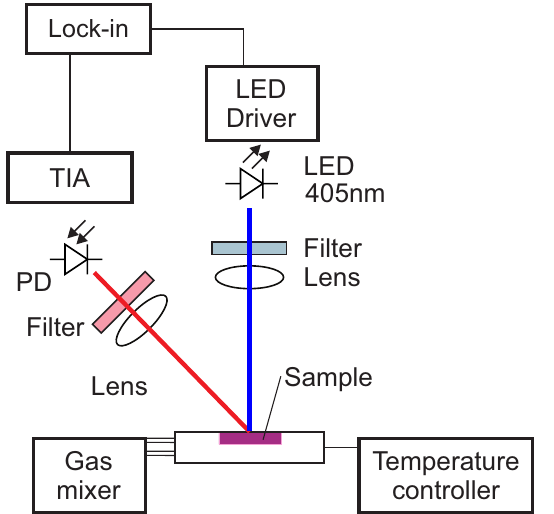
Figure 1. Scheme of the optical experimental setup. Blue is the excitation, red the luminescence optical path. PD, photodiode; TIA, trans-impedance